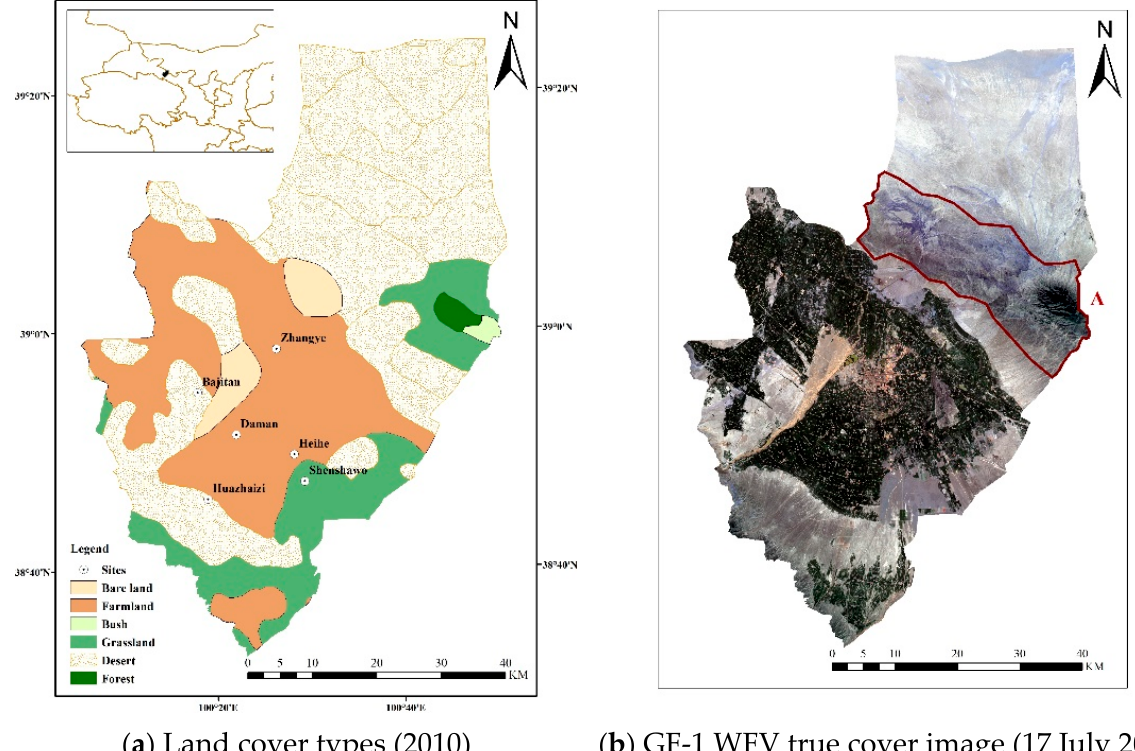
Figure 1. Land cover types of the study area and GF-1 WFVtrue color data image.